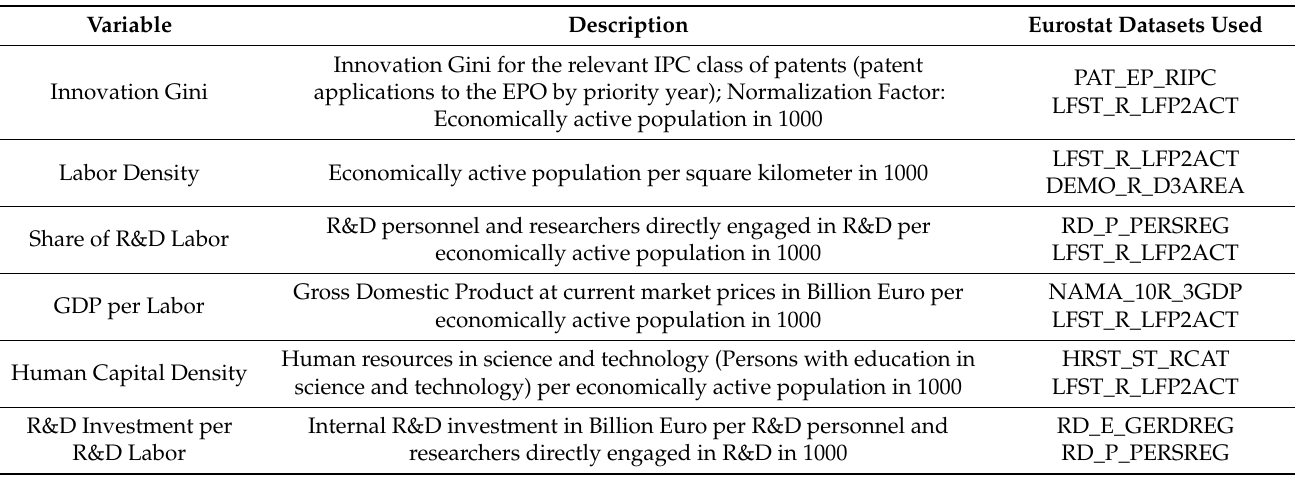
Table 1. Variable Declaration, source: Own calculations [50–52]. Variable Description Eurostat Datasets